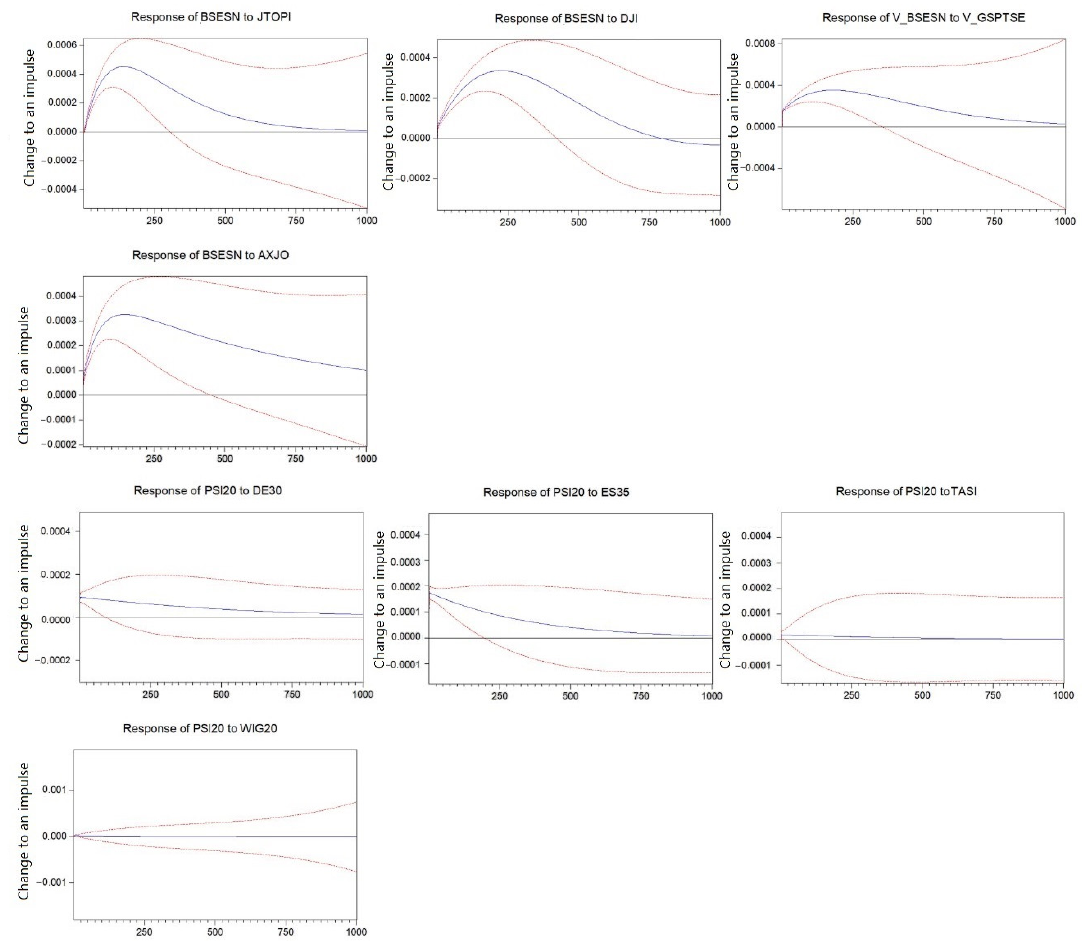
Figure 10. Impulse Response of var BSESN and var PSI 20 to selected stock indices. Note: Blue lines represent the predicted results; red lines represent one positive/negative standard deviation from the predicted